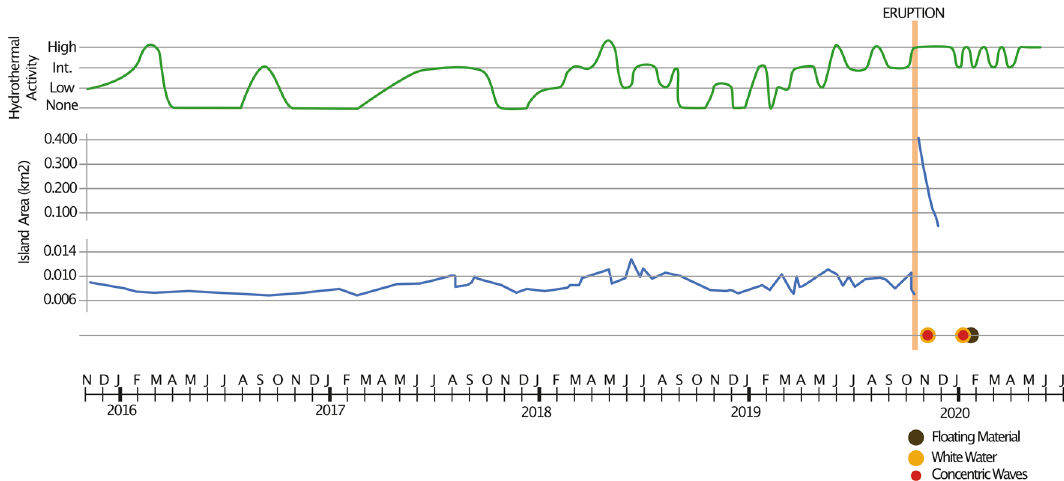
Figure 3. Satellite observations of hydrothermal venting intensity, island area, white water caused by phreatic activity, concentric ring waves and floating material plotted against time in the period before, during and after the 2019 eruption. Island areas are plotted on two separate scales as New Late’iki was considerably larger than the pre-eruption